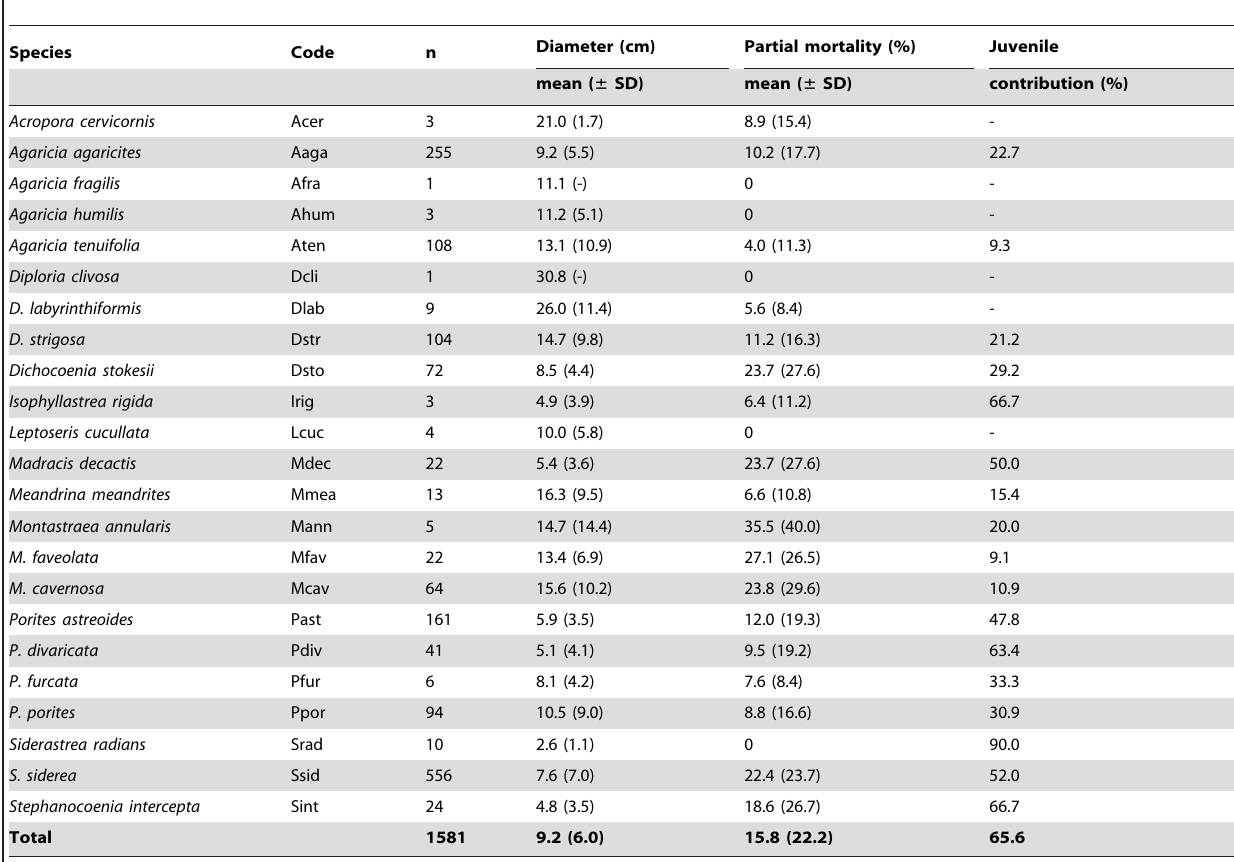
Table 1. Number of coral colonies (n), colony size (maximum diameter in cm), percent colony mortality and juvenile (colonies , 5 cm) contribution to the total number of colonies of each species in the coral-ground assemblage of Xcaret in